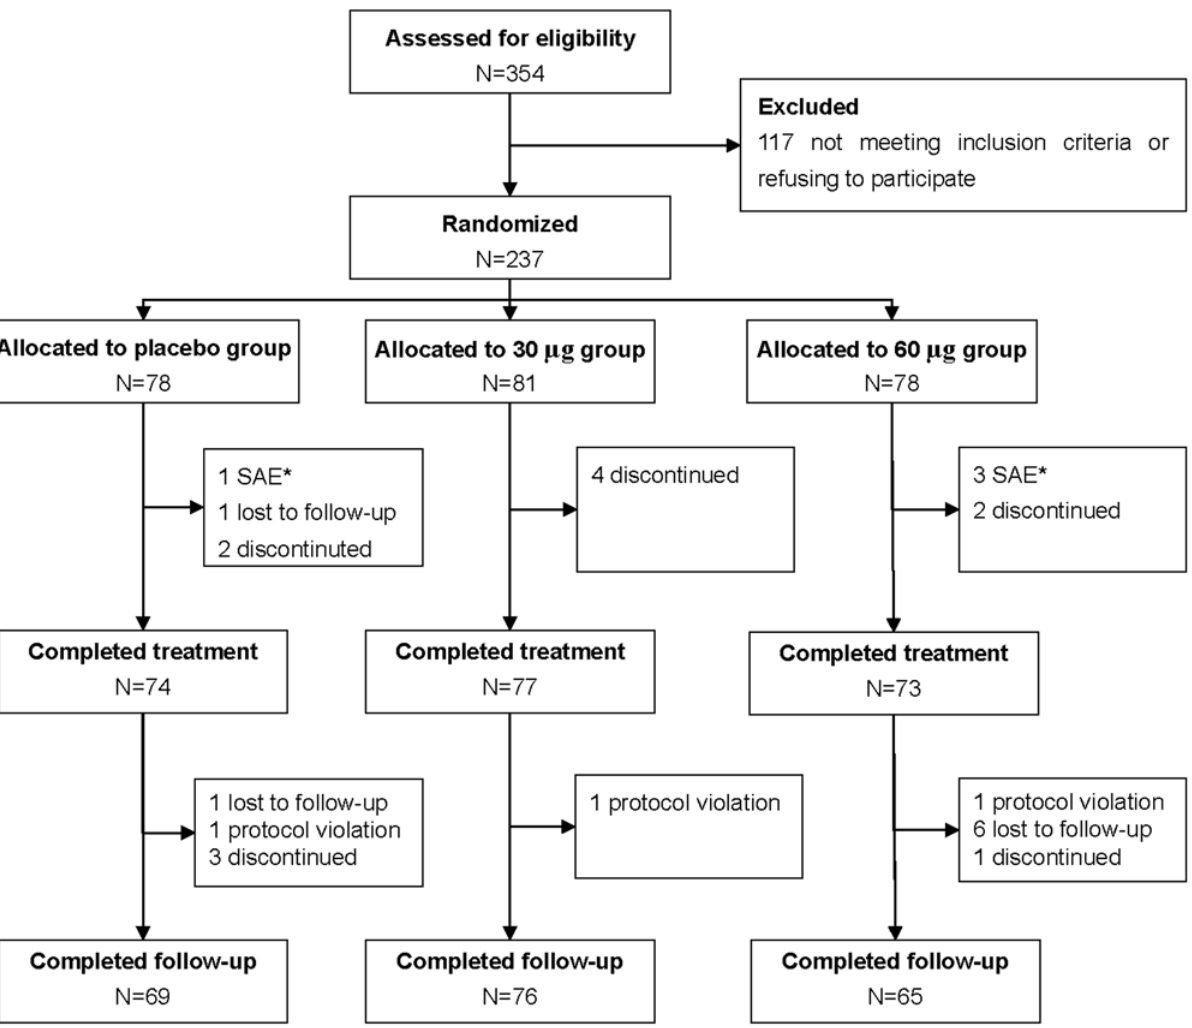
Figure 1. Summary of participants. Footnote: The numbers of SAE patients are those who discontinued treatment, while other SAE patients are not included in this figure. doi:10.1371/journal.pone.0002565.g001 5.0% (4/80) in the placebo, 30 m g YIC and 60 m g YIC groups Table 1. Characteristics of